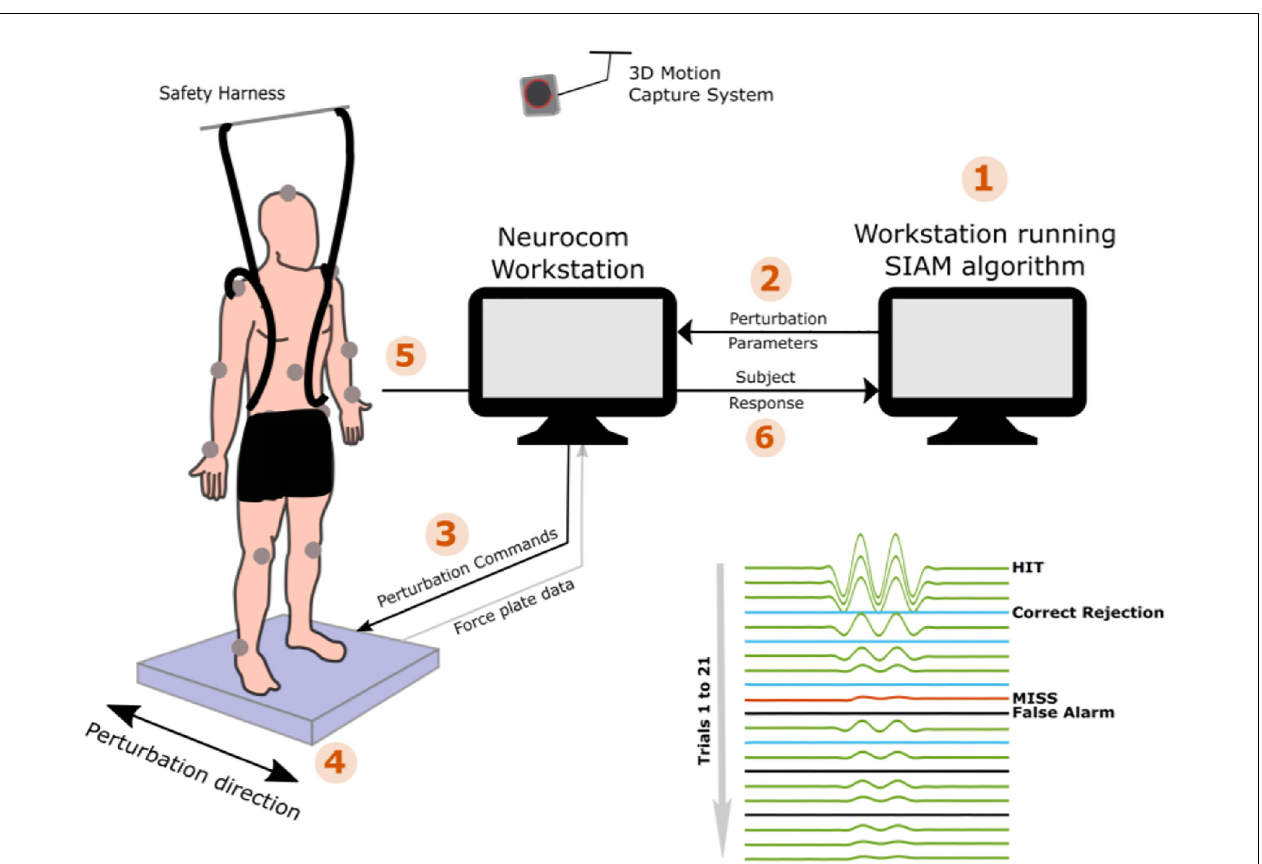
FIGURE 1 | The experimental set up and procedures are demonstrated for the PPT assessments of 0.5 Hz perturbations. (1) the assessment starts with the default perturbation amplitude of 4 mm, (2) perturbation amplitude is fed to the Neurocom computer which (3) sends out the command to the on-board controller for execution of the platform movement, (4) platform moves precisely at the desired amplitudes in the anterior-posterior direction, (5) the subject reports if he/she felt the platform movement, and (6) based on the correctness of subject’s response, SIAM algorithm computes the next perturbation amplitude and the steps 1–6 are repeated for the remaining 20